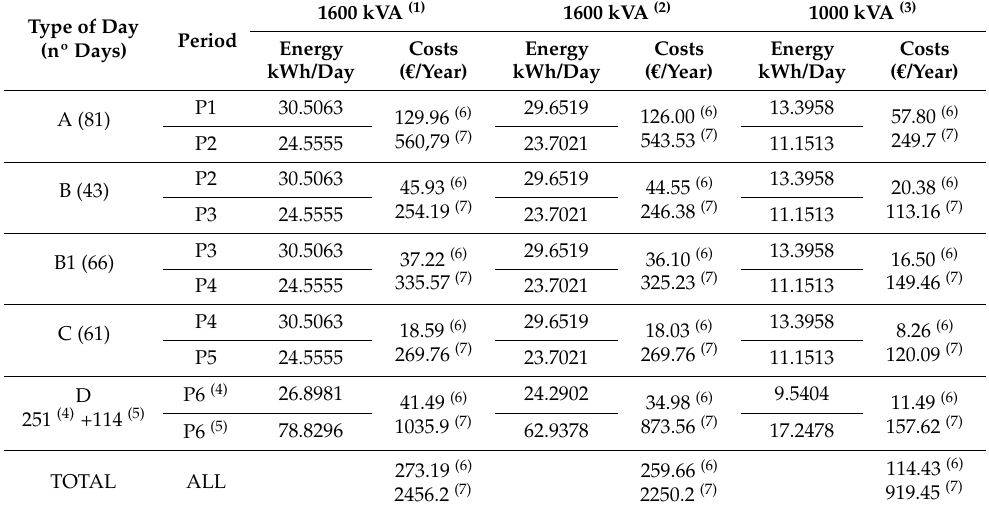
Table 14. Daily energies and annual costs for three analyzed transformers: 1600 kVA (1) with no improvements, 1600 kVA (2) with capacitor bank improvements and 1000 kVA (3) efficient transformer, on working days (4) and holidays (5) , corresponding to 2020 (6) and 2022 (7) energy prices. 1600 kVA (1) 1600 kVA (2) 1000 kVA (3) Type of Day Energy (nº Days) Period